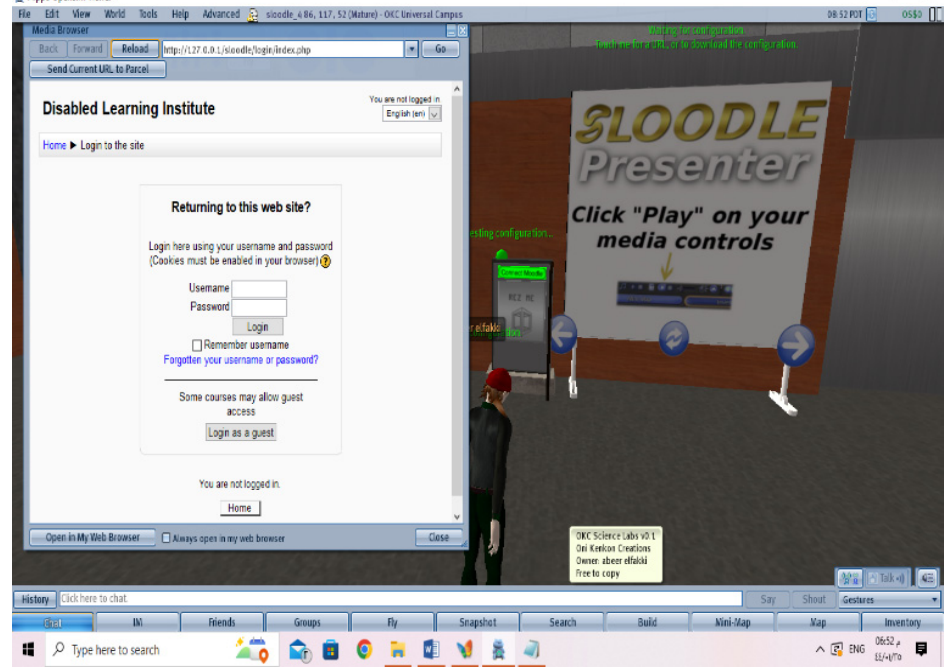
Figure 3. 3D virtual learning environment with